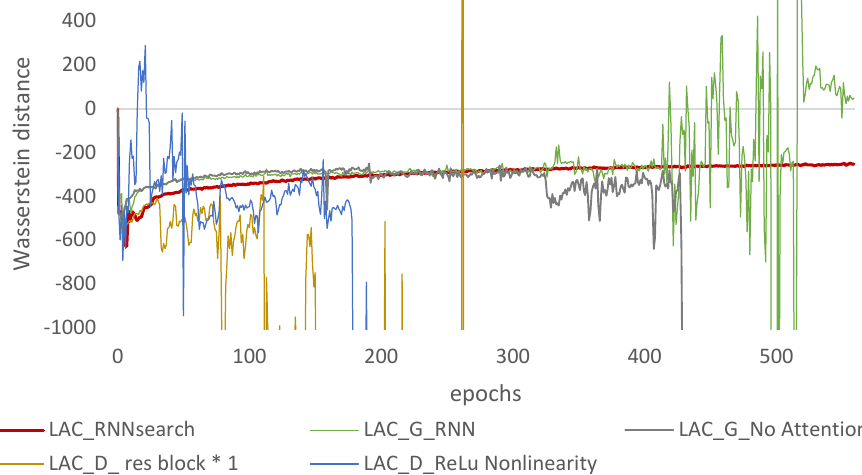
Figure 4. Wasserstein distance during the training on the validation dataset, plotted by every epoch. The critic ability is reduced in the ablation study against the discriminator (i.e., the gold and blue lines). The Wasserstein distance cannot be accurately measured as the curve is diverging. That is, the discriminator is unable to detect generated and real translation.